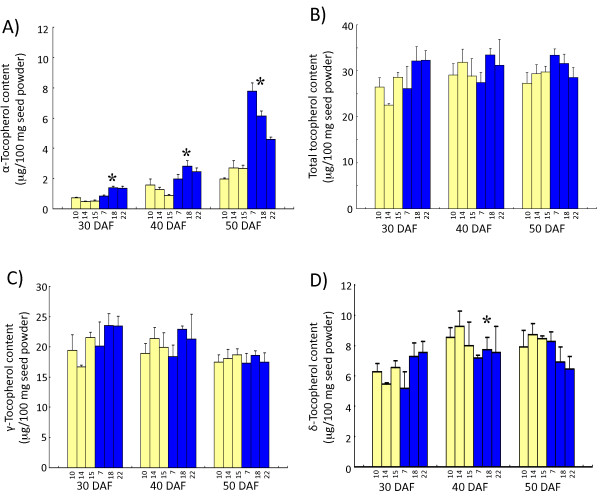
Tocopherol content in developing seeds of HIF-derived lines. Developing seeds of HIF-derived lines homozygous for either the Ichihime allele for γ-TMT3 (F5-24-10, F5-24-14, and F5-24-15; yellow bars) or the KAS allele for γ-TMT3 (F5-24-7, F5-24-18, and F5-24-22; blue bars) were used for analysis. Seeds were analyzed at 30 days after flowering (DAF), 40 DAF, and 50 DAF. The contents of α-tocopherol (A), total tocopherol (B), γ-tocopherol (C), and δ-tocopherol (D) were calculated as the weight per 100 milligram dry weight of seed. Data are represented as mean ± SD of the values obtained from triplicate experiments. For each development stage, significant differences between the Ichihime genotype group and the KAS genotype group (confidence interval 95%) are shown with asterisks.